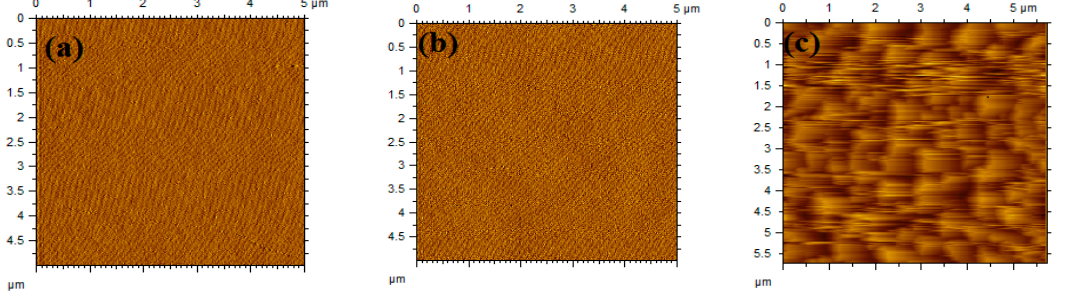
Figure 4. Atomic force microscopy (AFM) images of the GaAs surface by SF 6 plasma treatment. ( a ) without treatment; ( b ) 5 min and ( c ) 10 min.